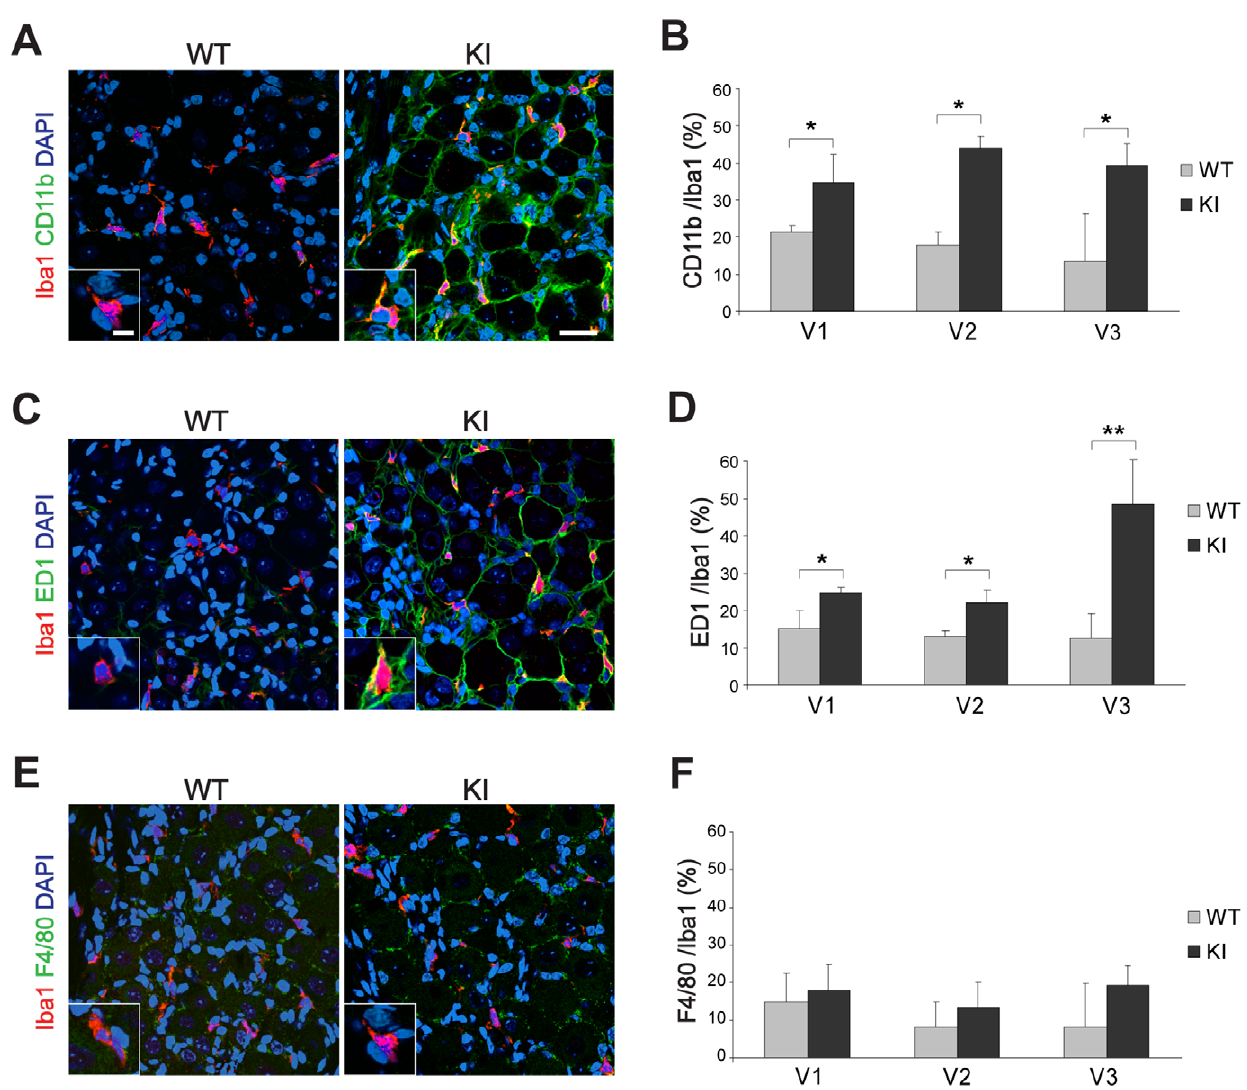
Figure 3. Characterization of Iba1-positive cells in trigeminal ganglia from WT and R192Q KI mice. A, C, E , Representative confocal images of WT or R192Q KI trigeminal ganglion sections (from V3 region) immunostained for Iba1 (red) and CD11b ( A ), ED1 ( C ), or F4/80 ( E ) in green. Nuclei were labeled with DAPI (blue). Scale bar: 40 m m. Insets represent larger magnification of immunoreactive Iba1 cells. Scale bar: 7 m m. B, D, F, Histograms quantify the percentage of occurrence of Iba1 signal with CD11b ( B ), ED1 ( D ) or F4/80 ( F ) in different WT and KI ganglion regions (V1, V2 or V3). Expression of different markers was quantified in Iba1 positive cells only. n =3 WT and 3 KI mice; * p , 0.05; ** p , 0.01. Data are expressed as mean 6